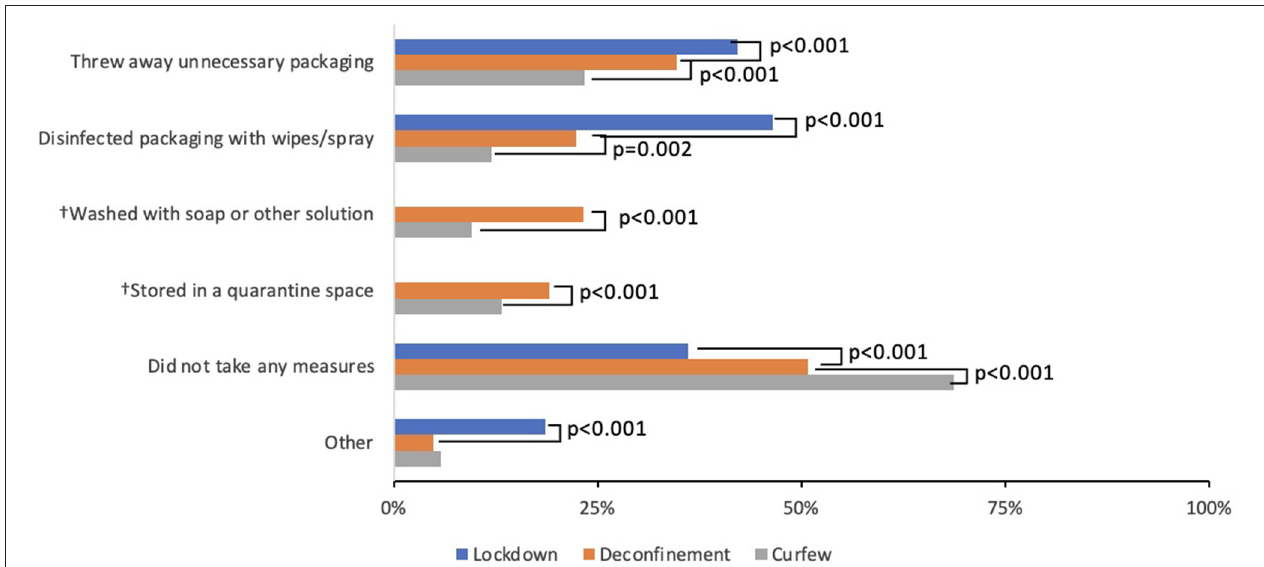
FIGURE 5 | Handling of groceries after purchase. “Between (time period) did anyone in your household take measures to disinfect product packaging after getting your groceries? ( Select all that apply)” McNemar test comparing Lockdown (blue) to Deconfinement (orange), and Deconfinement (orange) to Curfew (gray). † These options were identified as common themes from baseline free text responses to “Other (please specify)”, thus only deconfinement to curfew data are